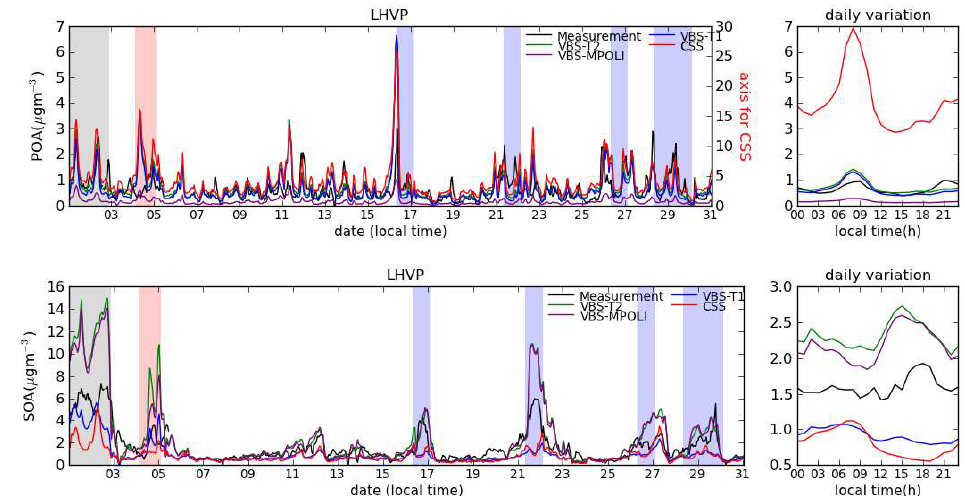
Fig. 12 Comparison of simulated and observed primary and secondary organic aerosol. Fig. 12. Comparison of simulated and observed primary and secondary organic aerosol.